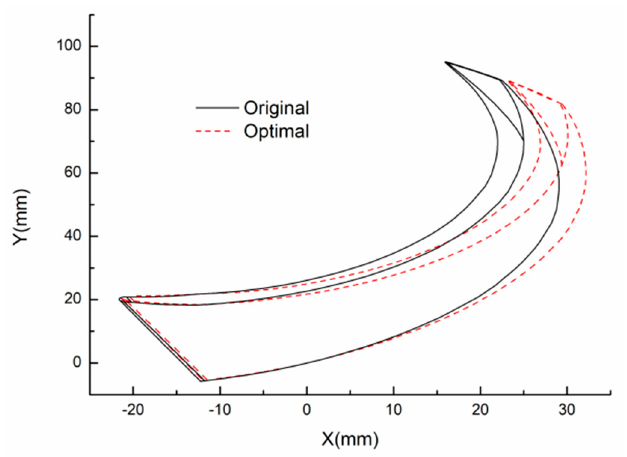
Figure 7. Optimal blade shape.